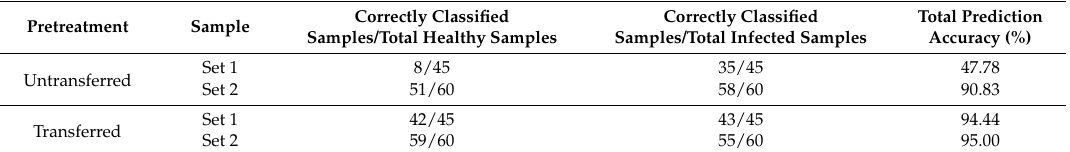
Table 5. The results of the SVM models built by using the full spectra of sample set 3 as the calibration set and the untransferred and transferred full spectra of sample sets 1 and 2 as the prediction